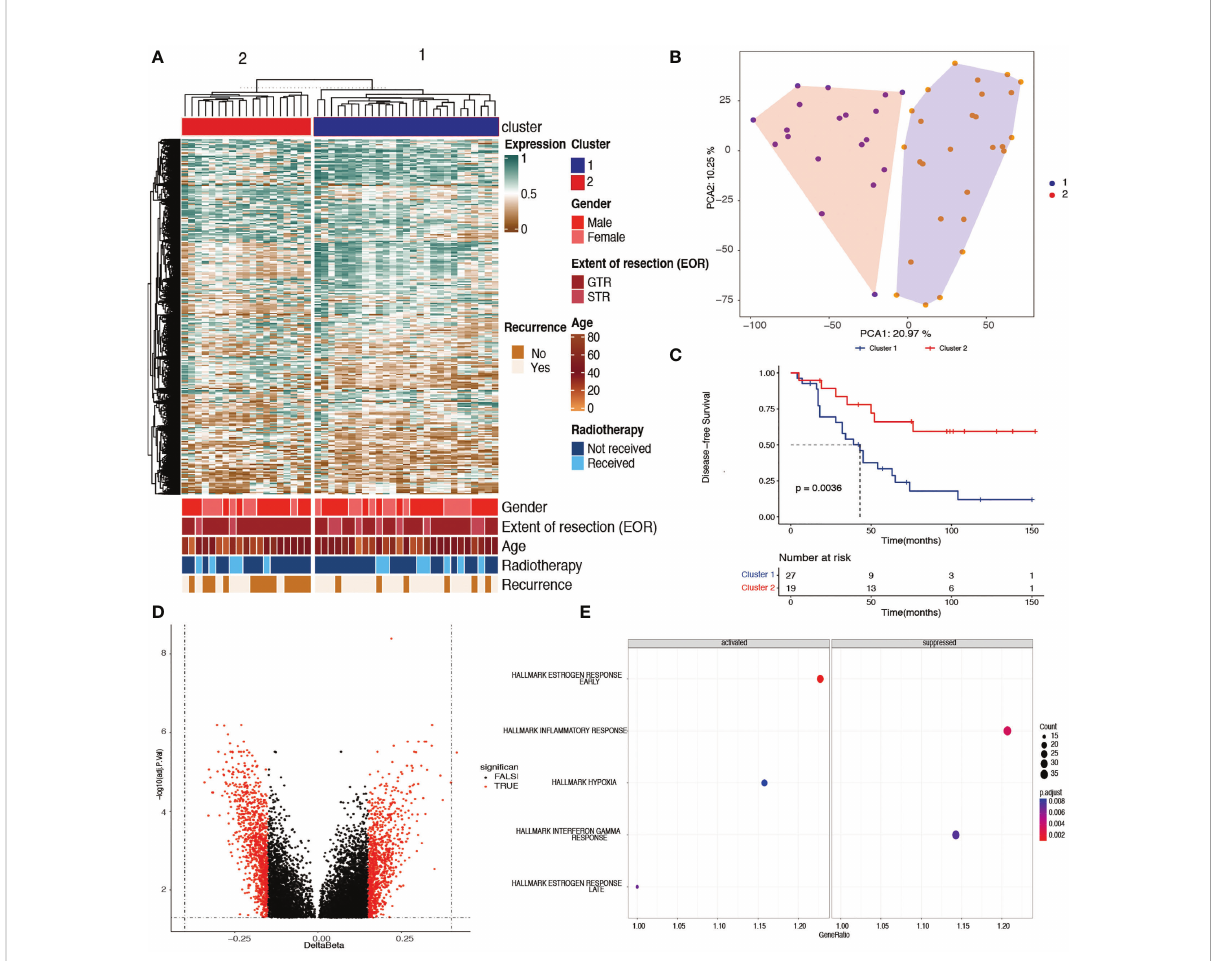
FIGURE 1 Identi fi cation of two prognostic chordoma subtypes with tumor DNA methylation signatures. (A) Unsupervised learning cluster identi fi ed two skull-base subtypes in the 46 DNA methylation samples with the most variable 10,000 probes. Color annotations display the distribution of clinical features (sex, age, extent of surgery, adjuvant radiotherapy, and the recurrence status). (B) Principle component analysis results of the cohort samples showed that the samples within cluster 1 were well separated from the samples within cluster 2, with the top 10,000 most variable methylated probes. (C) Kaplan – Meier plot showing cluster 1 had a worse disease-speci fi c survival time when compared with cluster 2 ( p < 0.01). (D) Volcano plot showing 1,496 probes with differentially methylated promoters between cluster 1 and cluster 2. (E) Gene set enrichment analysis revealing the activated and suppressed pathways within hallmark gene sets in cluster 1 when compared with cluster 2. The early and late estrogen response pathways and the hypoxia pathway were activated, whereas the in fl ammatory and interferon gamma responses were suppressed in cluster 1 (adjusted p <